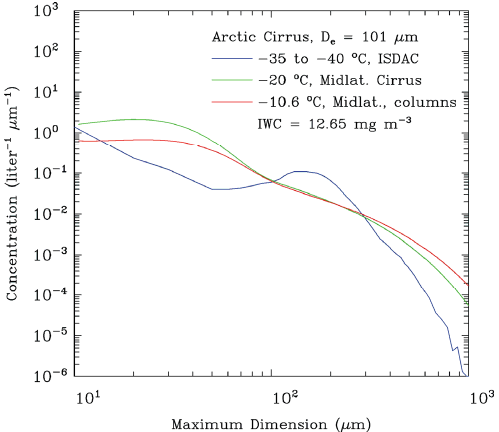
Figure 13. Wavelength dependence of Q ext for the 3 PSD described in Fig. 11, using the same color convention and MADA optics. All PSD have the same D e and IWC.